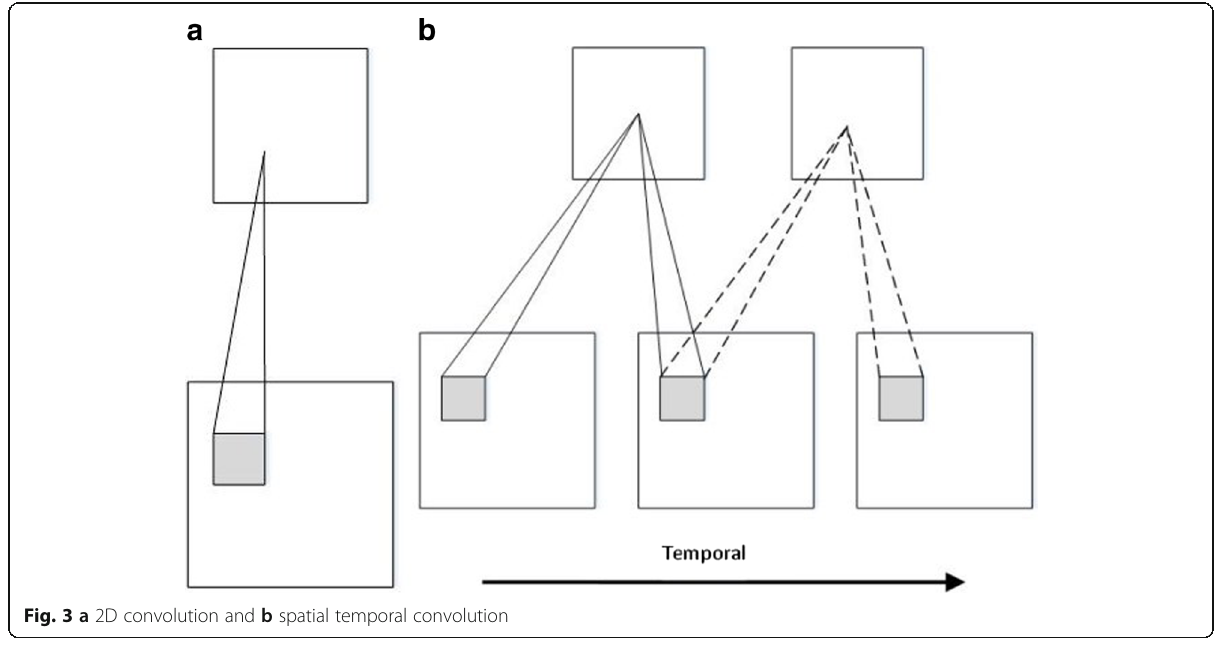
Fig. 3 a 2D convolution and b spatial temporal convolution